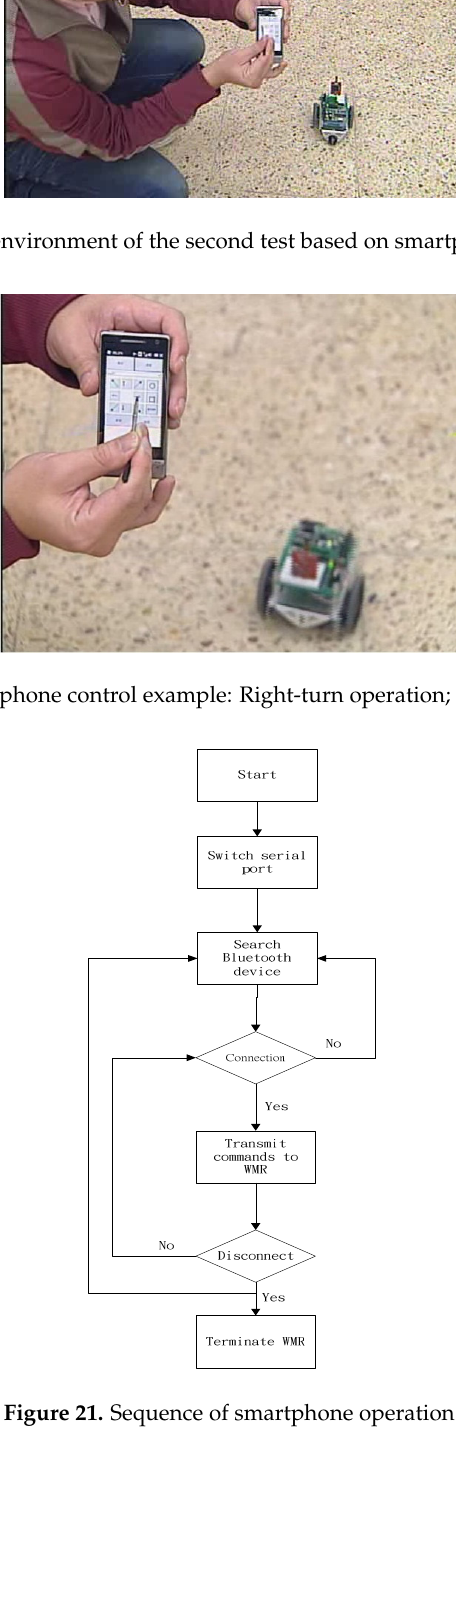
Figure 22. Sequence of WMR operation. The first and second experiments described above are manually operated. The following three experiments are autonomous control. The flowchart of the automatic dynamic tracking control sequence is shown in Figure 6, whereas the flowchart of the automatic indoor patrol control sequence is shown in Figure 11. In dynamic tracking, Figure 23 shows the tracking operation. Figure 24 shows the images on the PC screen that are captured by the robot ′ s camera.